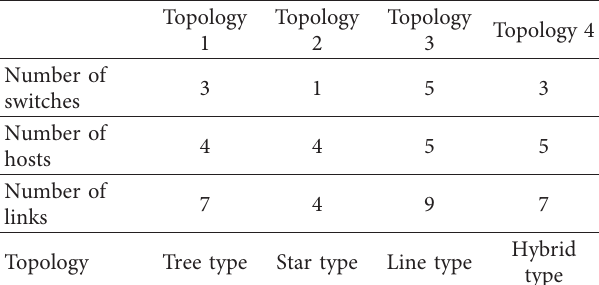
Figure 2: The network anomaly detection model based on deep learning in future network. Table 1: Network